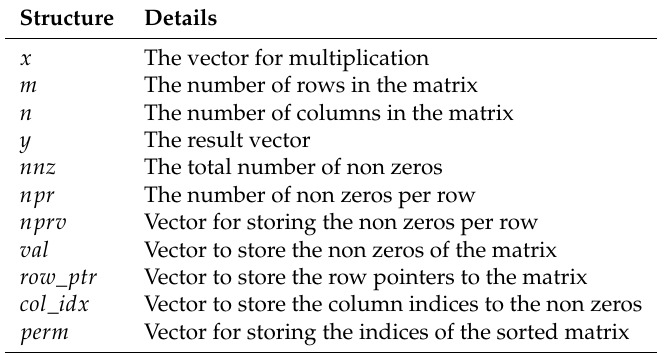
Table 2. The terminology and data structures used for matrix